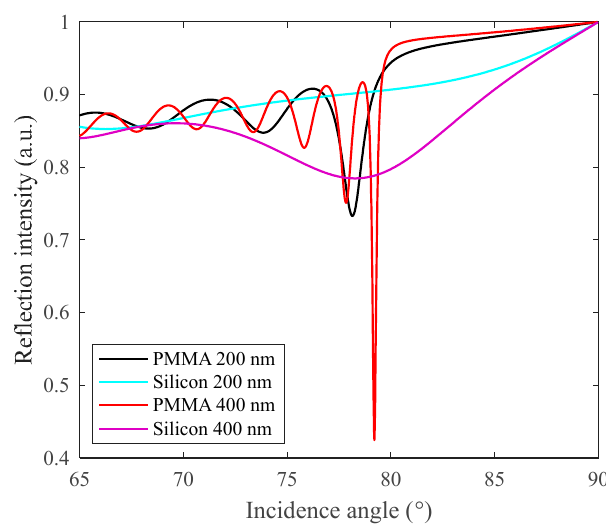
Figure 3. Reflectance curves of 1DPC having the first constituent material as graphene and different thicknesses of the second constituent material, either PMMA or silicon.